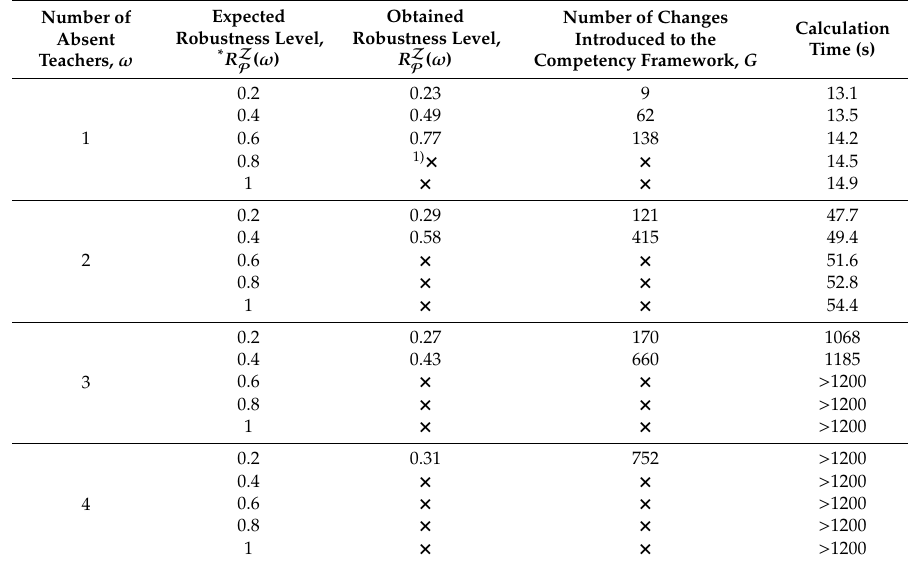
Synthesis of competency framework, G OPT , following robustness level